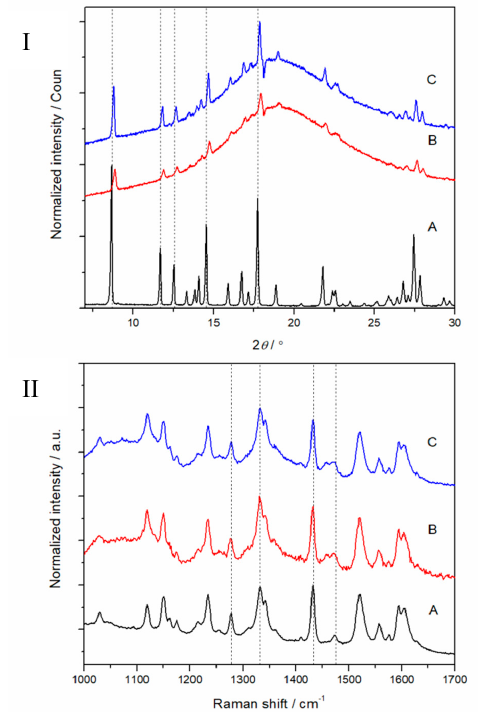
Figure 4. XRD patterns ( I ) and Raman spectra ( II ) of piroxicam (PRX)-loaded polydextrose (PD) fibers. Key: ( A ) PRX anhydrate form I (PRXAH I); ( B ) Fibers immediately after preparation; ( C ) Fibers stored for 30 days at 0% room humidity (RH) and low temperature (6 ° C).